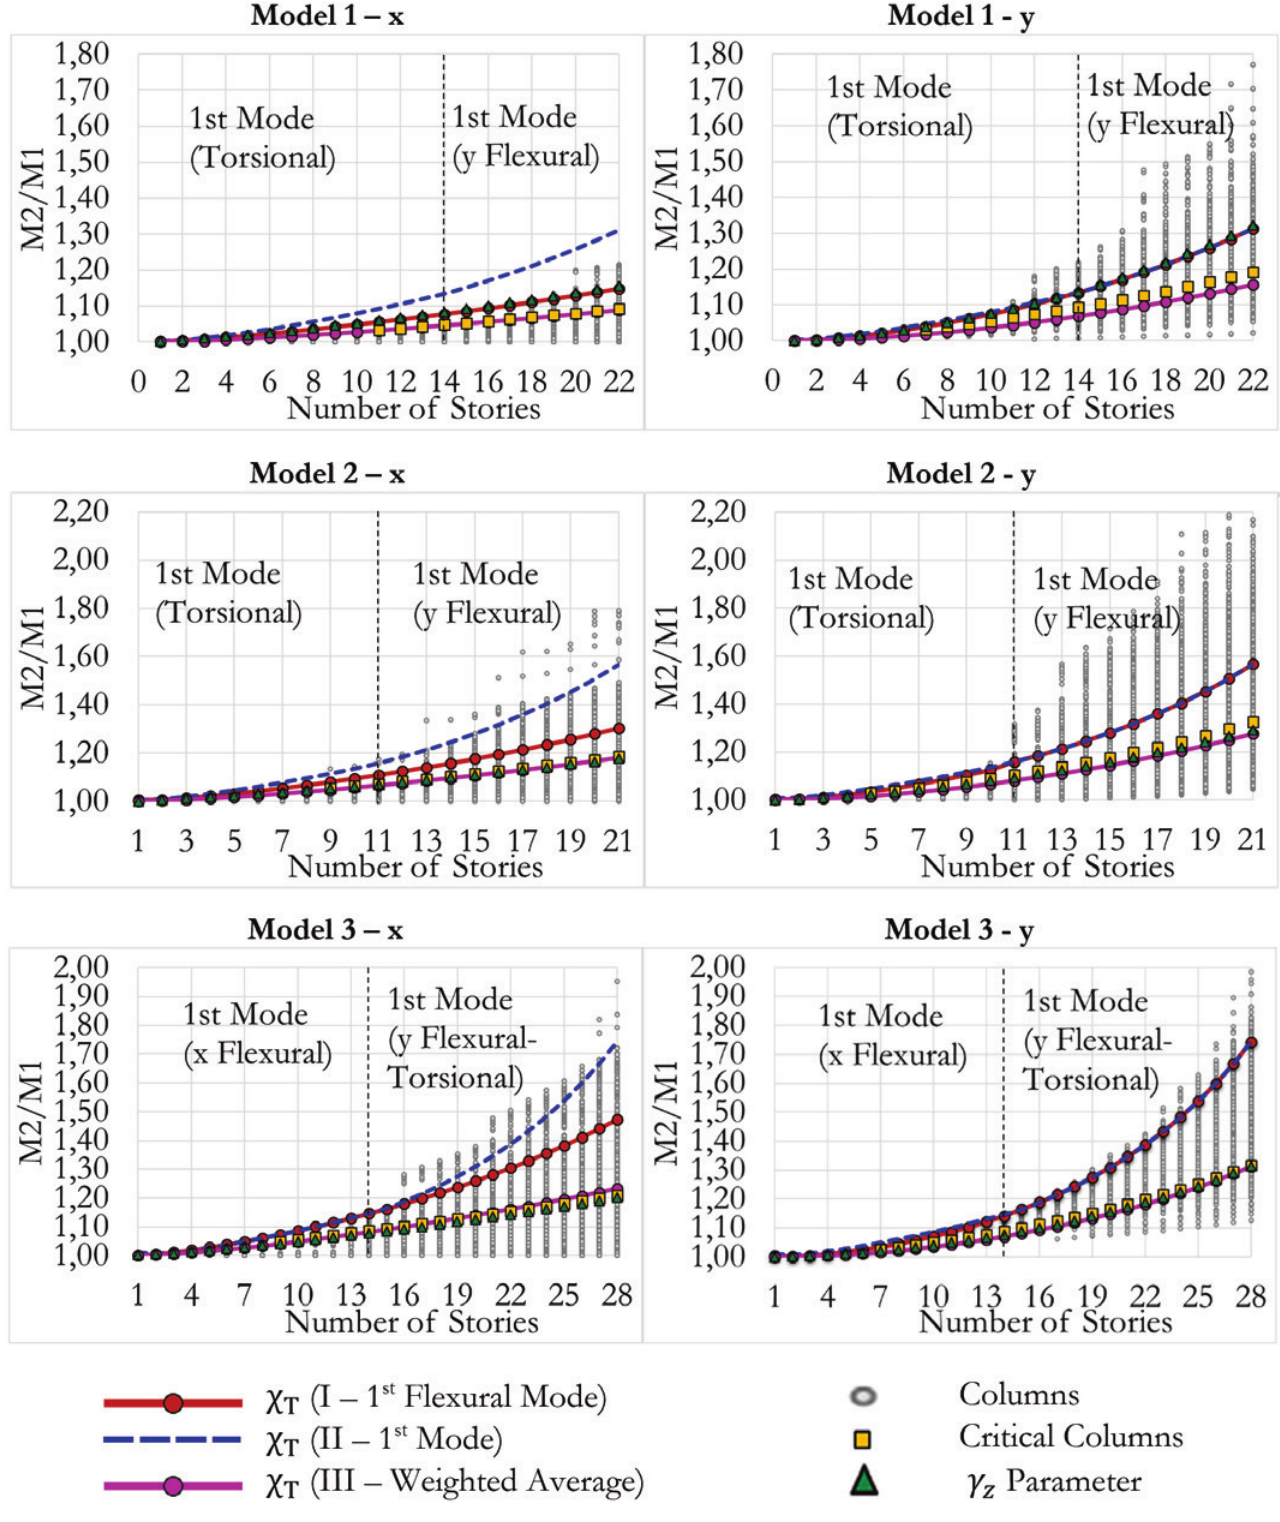
Figure 10 Moment amplification M Models 1, 2,